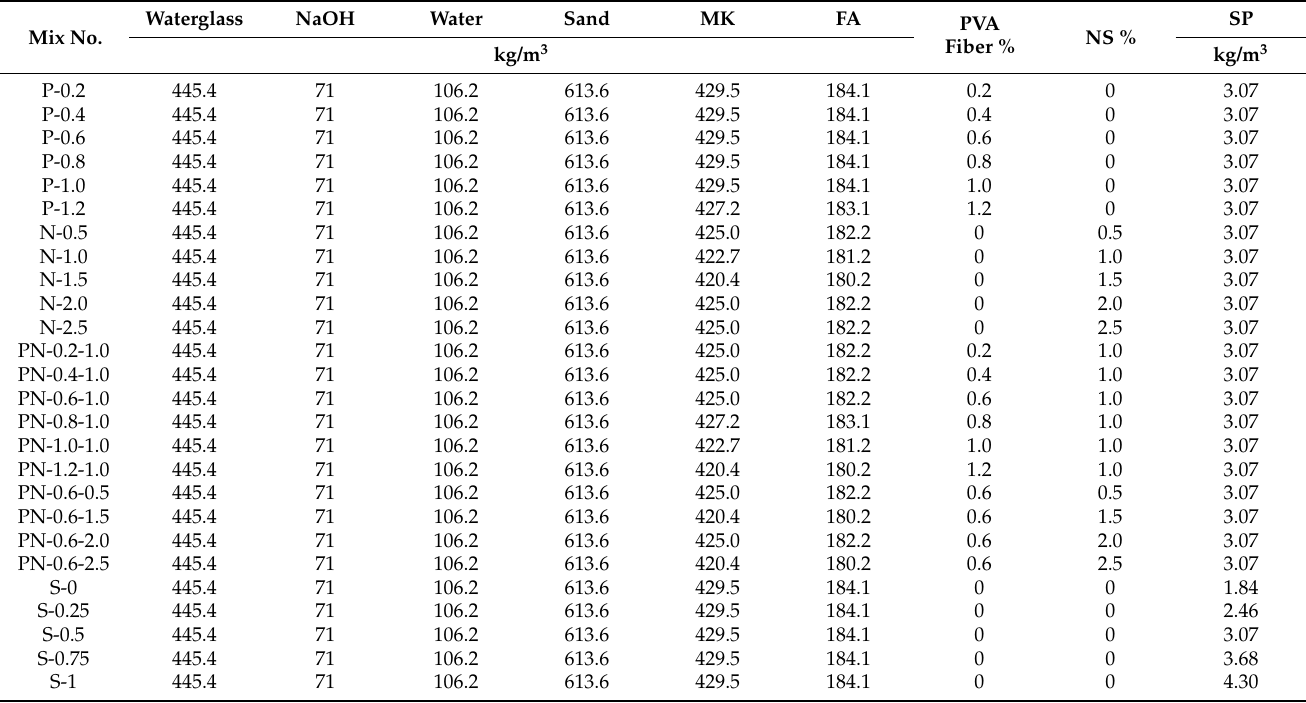
Table 2. Mix proportions of geopolymer